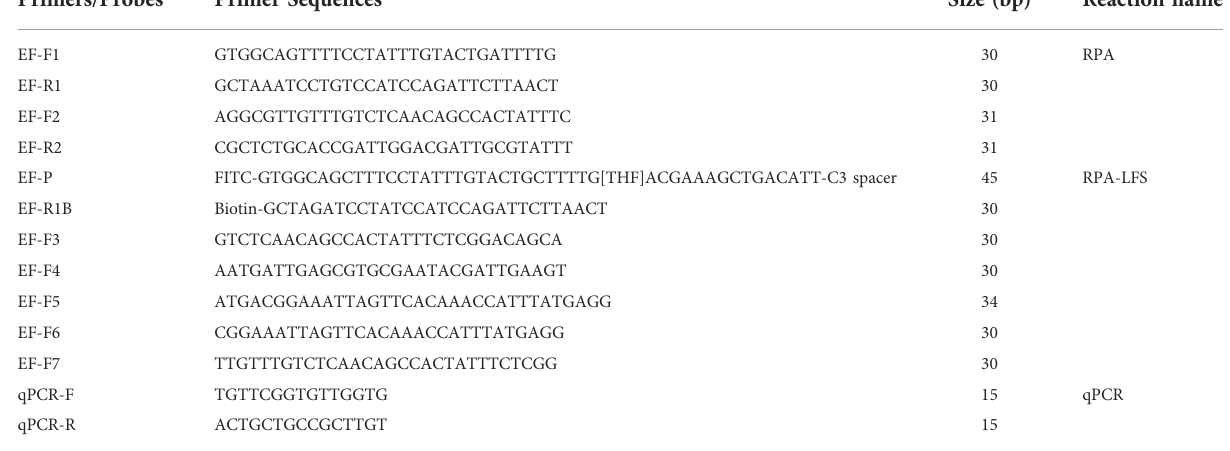
TABLE 2 Primers and probes.